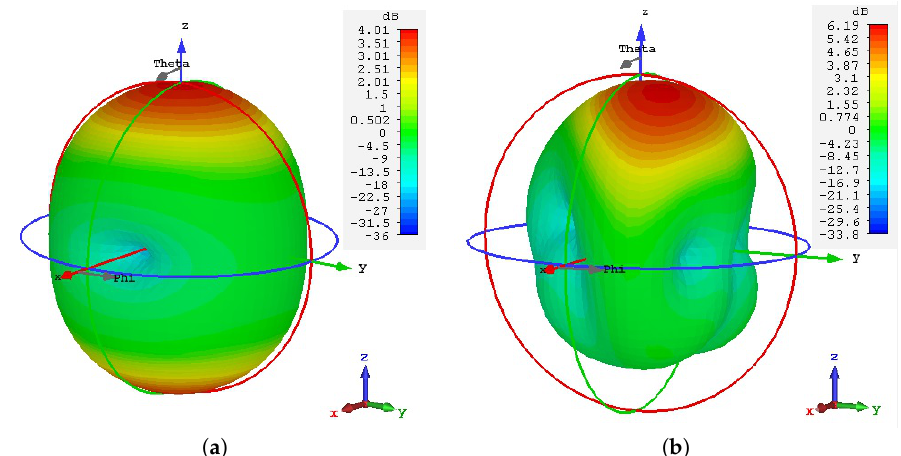
Figure 24. 3D view of the numerically computed gain pattern for: ( a ) wearable loop antenna alone (without HIS structure); and ( b ) loop antenna with HIS structure (as shown in Figure